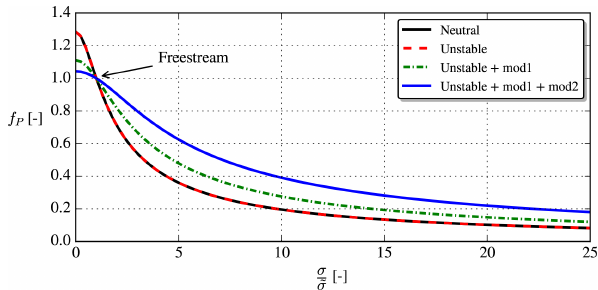
Figure 8. Analytical form of the f P correction as function of nor- malized shear parameter ( f P is independent of TI but depends on ζ ; the unstable curves use ζ ref = − 0 . 5 in this plot). The effect of stability-dependent ˜ σ (Eq. 25), modification 1 (Eq. 26) and mod- ification 2 (Eq. 27 with C B = 10 . 0) is